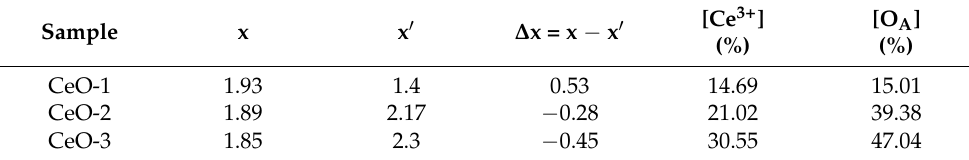
Table 2. Summary of XPS parameters of cerium oxide